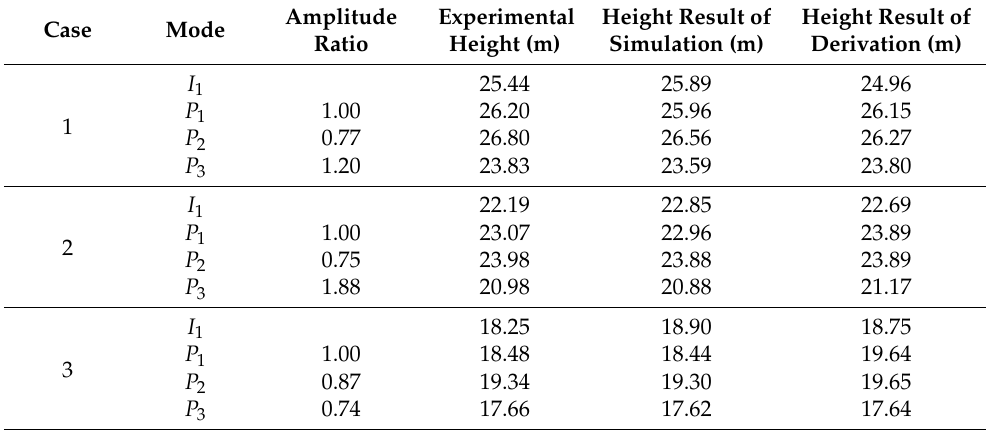
Table 4. Three kinds of height of selected